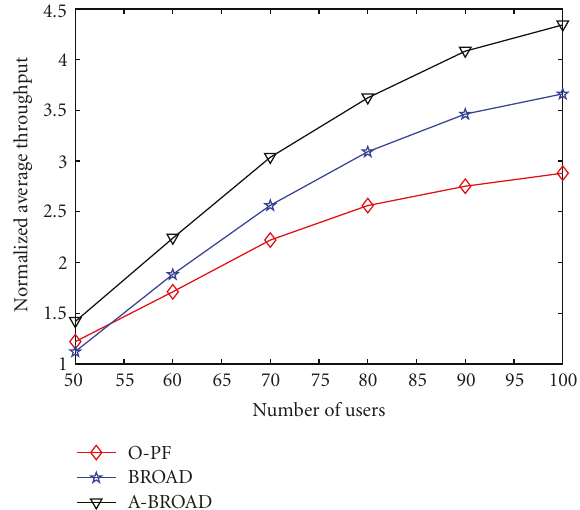
Figure 8: Normalized average achieved throughput versus the number of